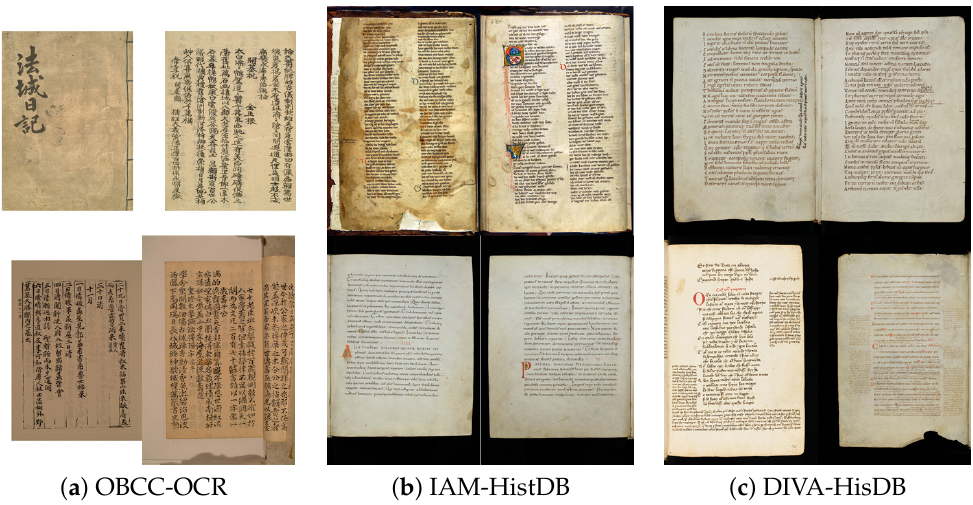
Figure 2. A part of images from text image datasets used in our